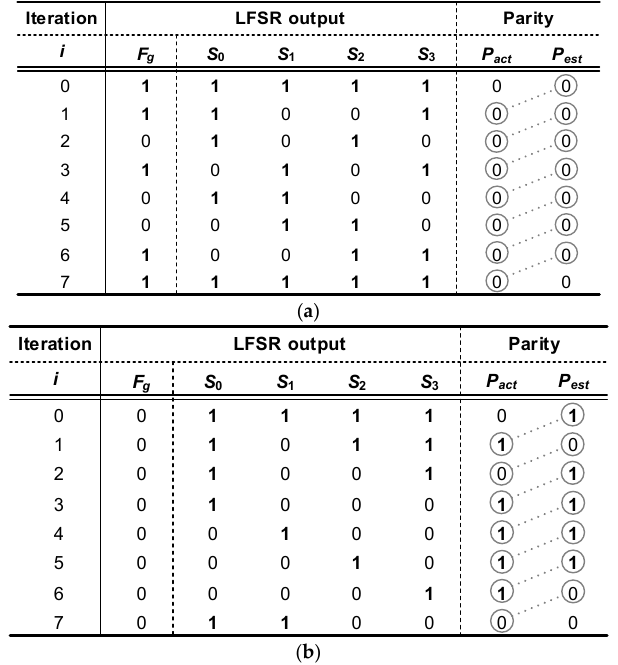
Figure 5. Proposed error detection LFSR (ED-LFSR) operation at ( a ) even generator polynomial x 4 + x 2 + x + 1; ( b ) odd generator polynomial x 4 + x + 1.